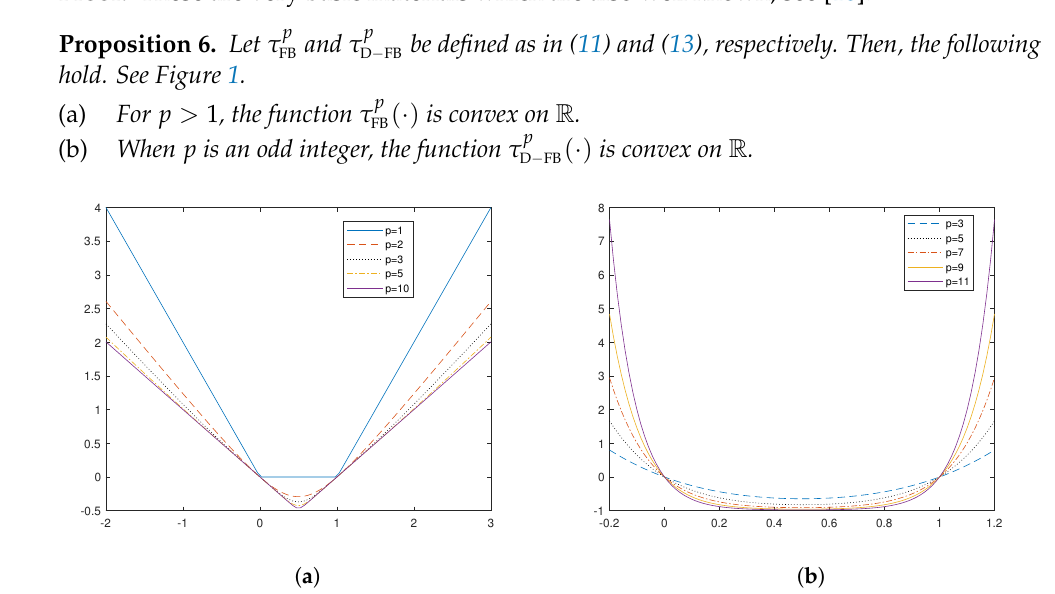
( x ) with different values of p ; FB